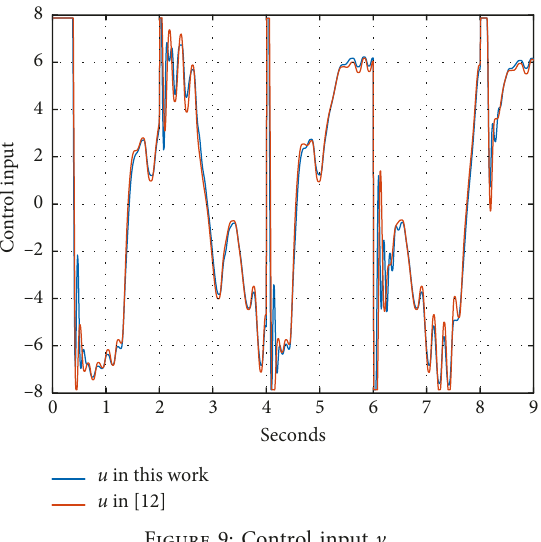
Figure 6: Control input v .